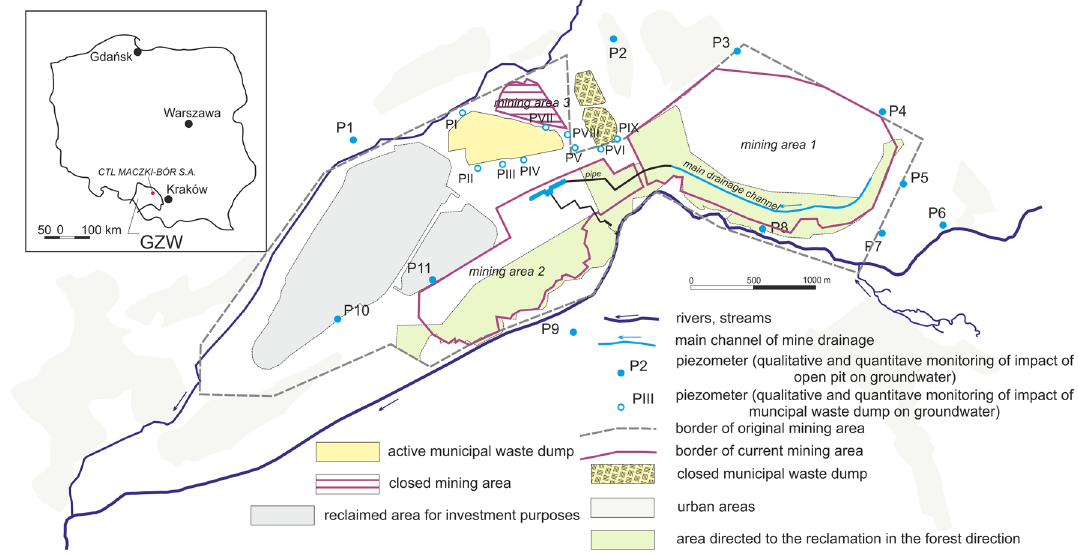
Fig. 1 Map of the location of the mine drainage network, groundwater monitoring and excavation development